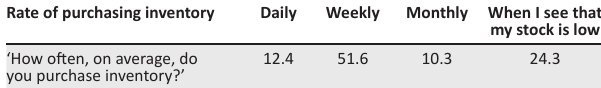
TABLE 3: Respondents’ rate of purchasing inventory. Rate of purchasing inventory Daily